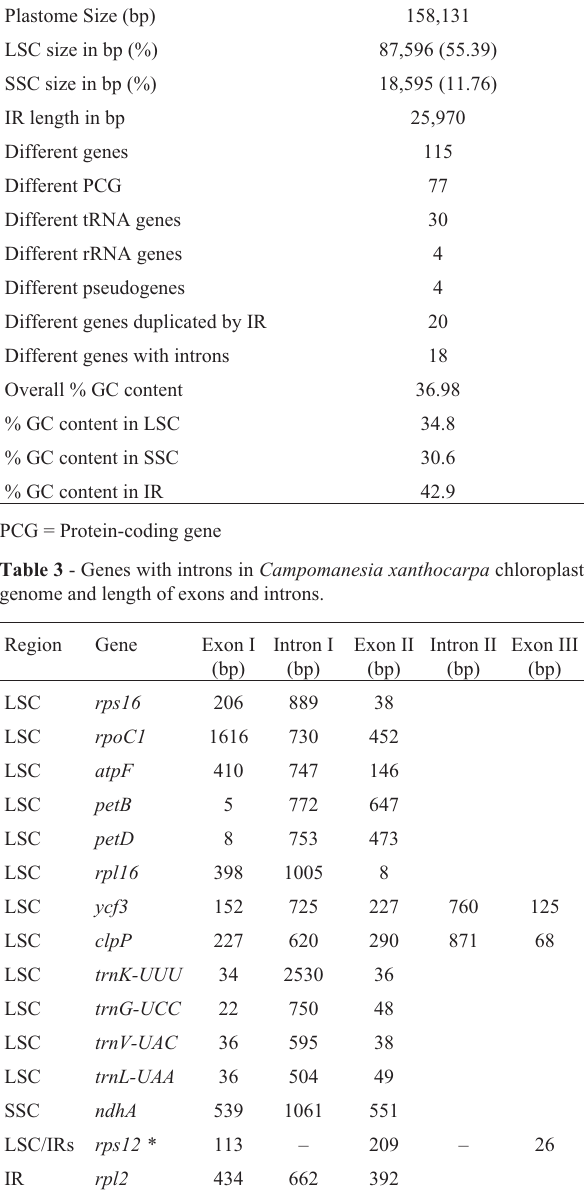
Table 2 - Summary of Campomanesia xanthocarpa chloroplast genome characteristics. Characteristics of plastome